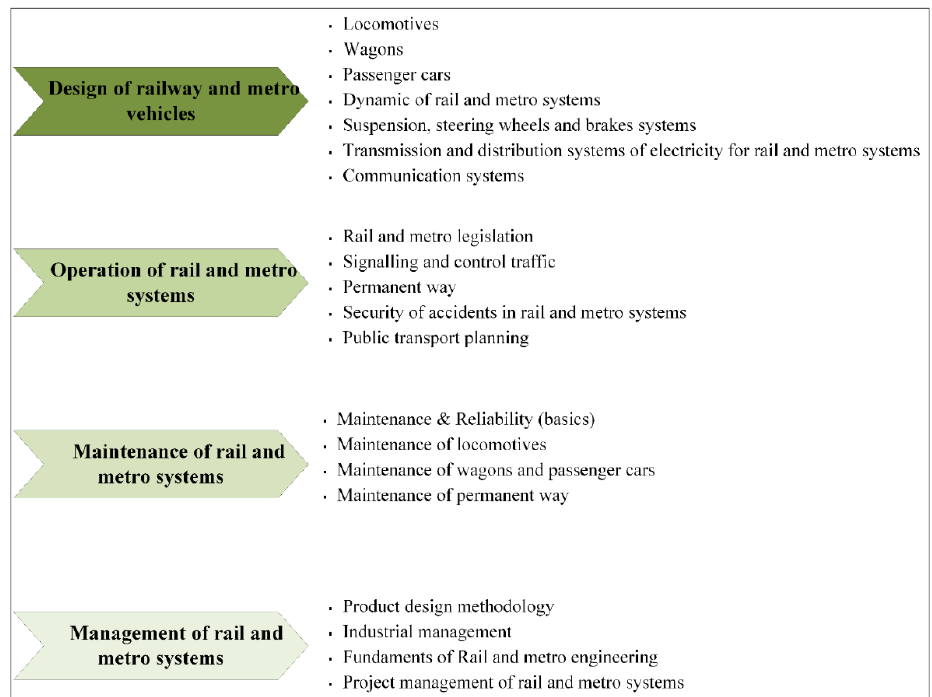
Figure 2. Areas and structural attributes of the course subjects of the Railway Engineering and Metro program at